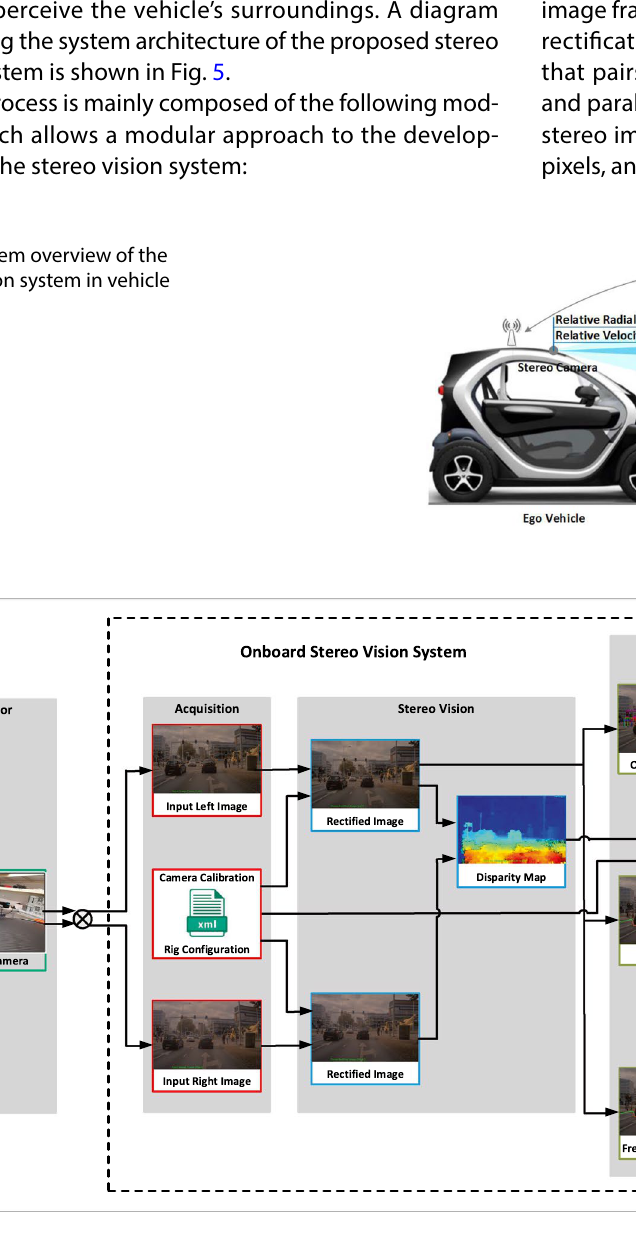
Fig. 5 System architecture of the stereo vision